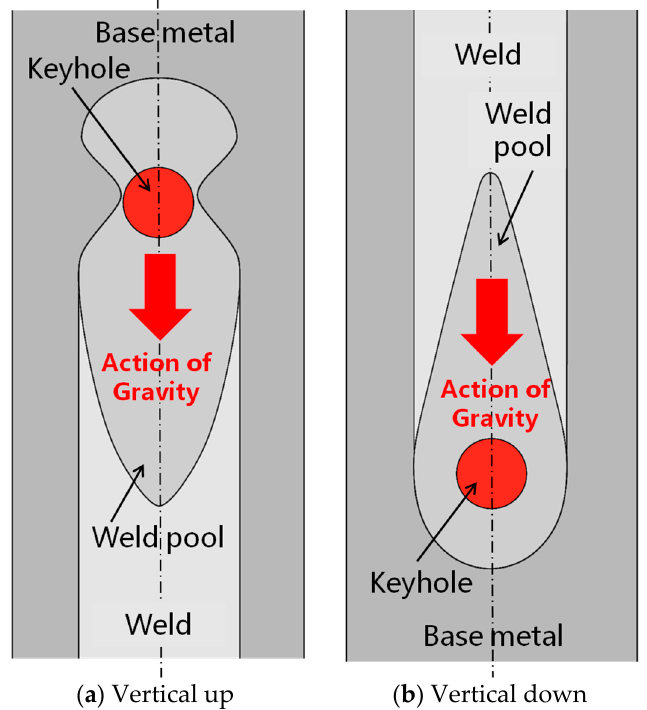
Figure 8. Schematic representations of the actions of gravity on molten metal in different welding positions.